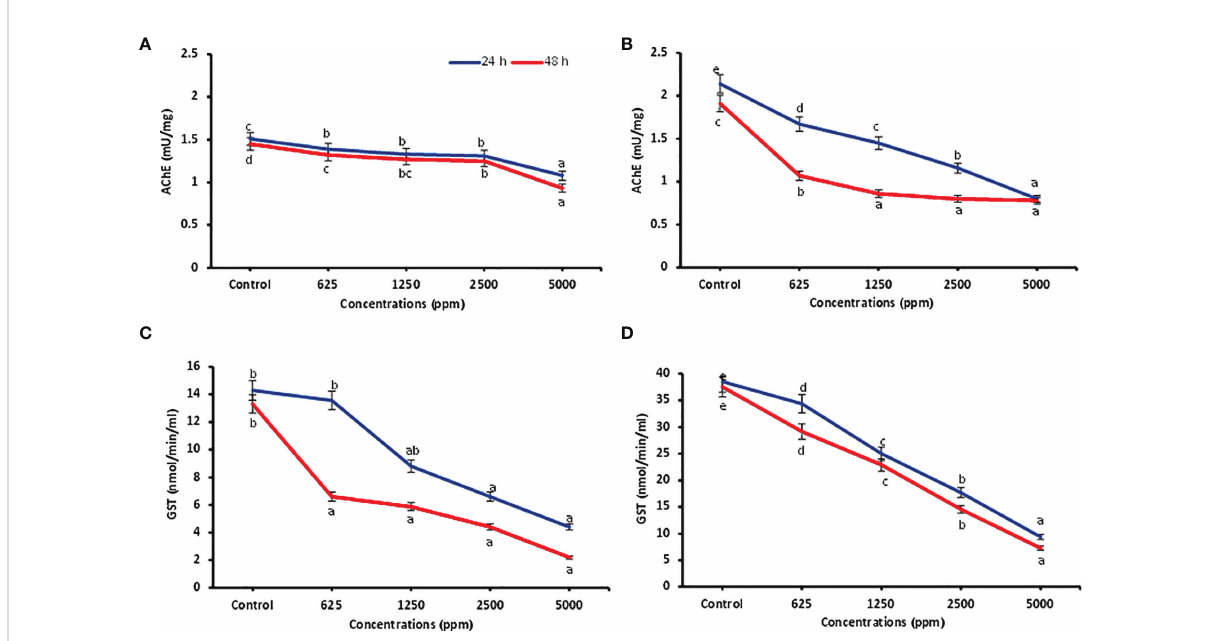
FIGURE 2 Detoxi fi cation enzyme inhibition activities. AChE inhibition in P. lilacinus treated with ocimene (A) and b -myrcene (B) . GST inhibition in P. lilacinus treated with ocimene (C) and b -myrcene (D) . Bars represent the standard error ( ± SE) of three replications. Means followed by the same letters within a column do not differ signi fi cantly by Tukey ’ s HSD test (p >